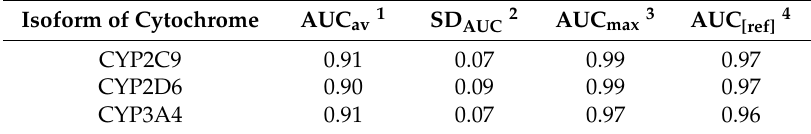
Table 2. Comparison of the performances of QNA-based approach and the results reported in Tyzack et al. showing the average and the best AUC values obtained based on the leave-one-out cross-validation.